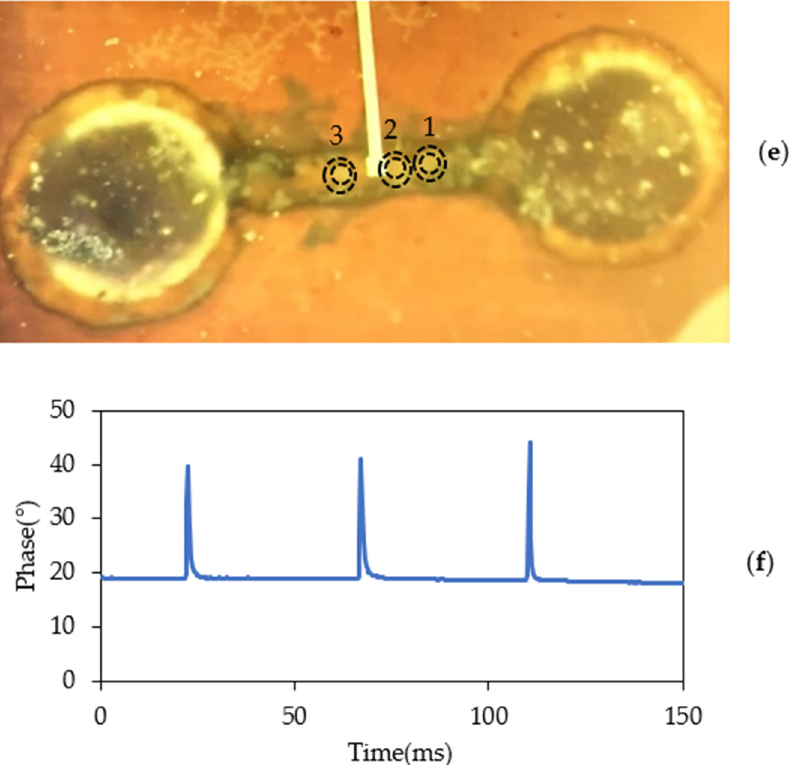
Figure 11. Real-time measurements of a single C1498 cell: ( a – c ) are optical microscope images captured by the high-speed camera displaying a C1498 cell (indicated by black circles and arrows) entering the microchannel from the inlet (left), crossing the sensing region, and moving forward toward the outlet (right), respectively; ( d ) displays the real-time measurement of phase data of a single cell moving forward in a channel for each time point from ( a – c ) in 50 ms; ( e ) displays an image of three cells (circled in black) during the same pass through the microfluidic channel; ( f ) shows the phase data from the biosensor showing a total of 3 consecutive cell passes.